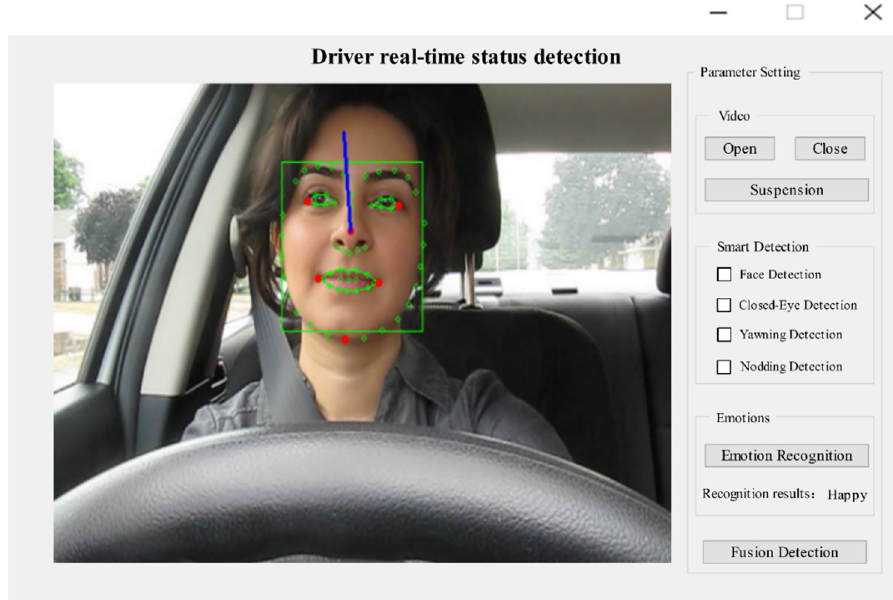
Figure 15. Test video number.